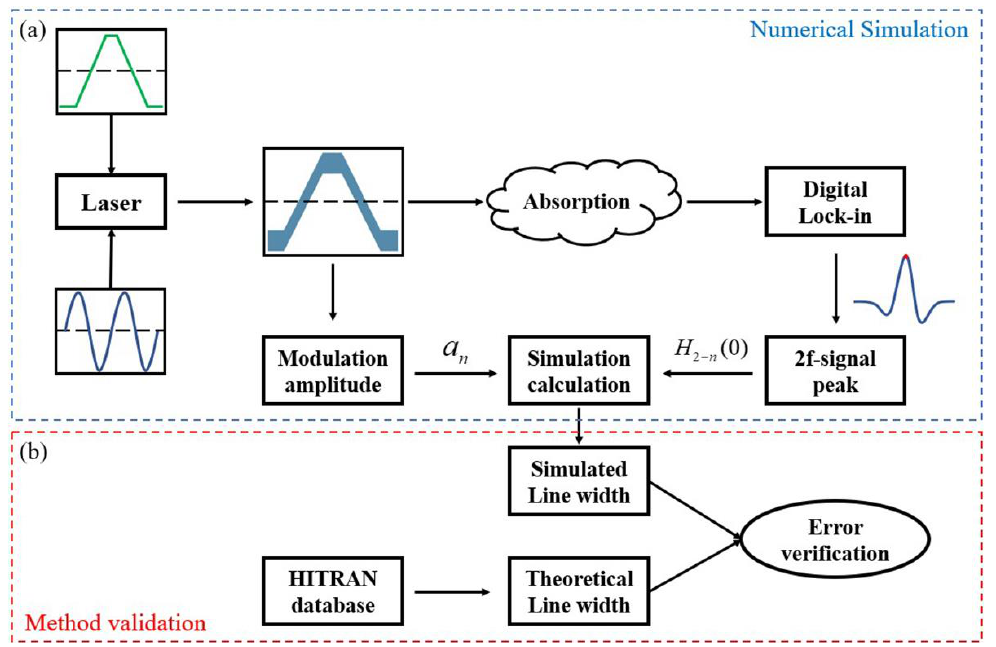
Figure 1. Simulation process. ( a ) Numerical simulation of harmonic signal; ( b ) Simulation validation of the proposed method.